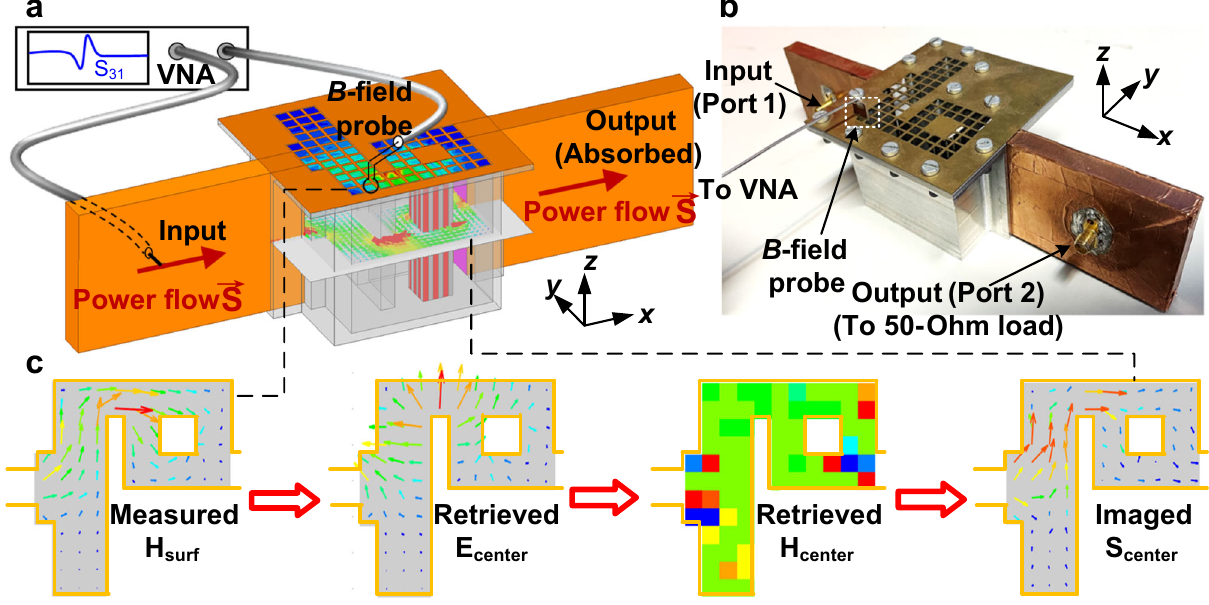
Fig. 1 | Conceptual sketch of the experimental system and data processing method. a The experimental equipment includes an epsilon-near-zero (ENZ) waveguideforideal fl uidpower fl ow,inputandoutputwaveguides,a B - fi eldprobe, andavectornetworkanalyzer(VNA).Thecentralplaneofthewaveguideshowsthe